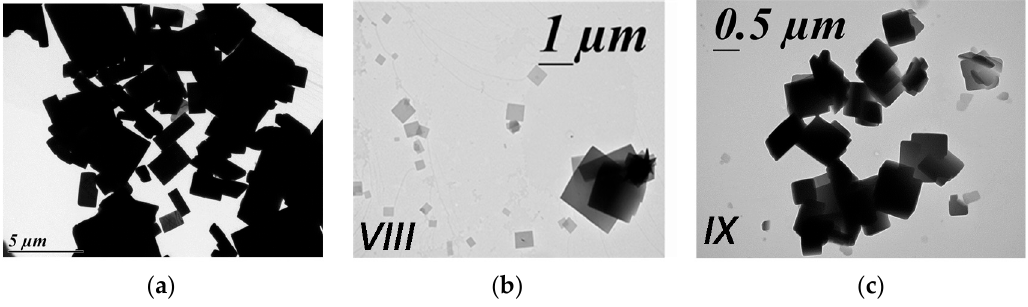
Figure 8. TEM images of the mononuclear SCO [Fe(bpp) 2 ](NCS) 2 ·2H 2 O particles ( a ) before the SD process and ( b , c ) obtained from spray-drying for the for batches VIII and IX .